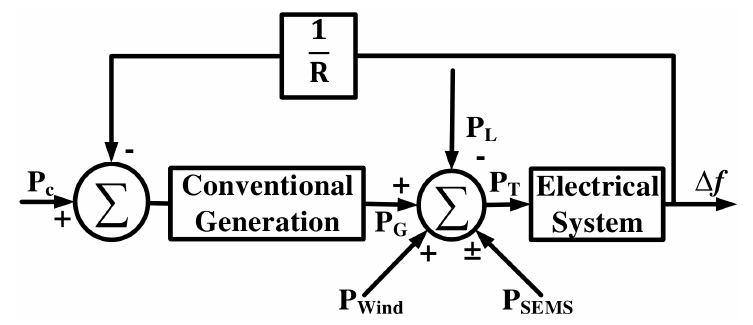
Figure 2. Island hybrid power system model.